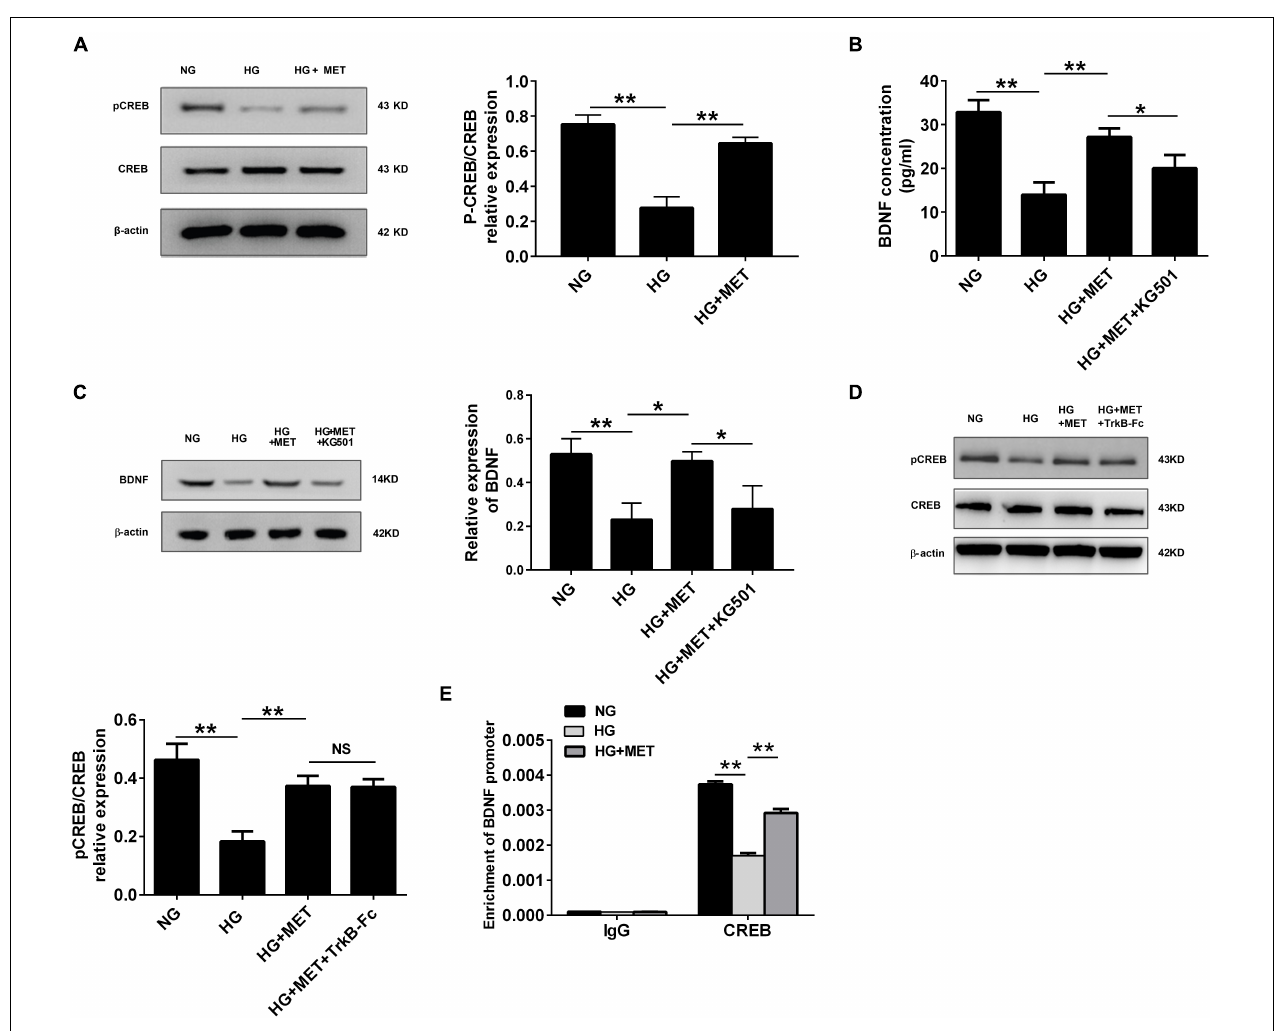
FIGURE 5 | BDNF expression was regulated by metformin through CREB activation. (A) Western blot analysis of CREB and pCREB expression in HUVECs treated with NG, HG (33.3 mmol/l), and HG + MET (0.01 mmol/l) conditions. Histograms represent the relative pCREB/CREB intensity. (B) ELISA analysis of BDNF expression in HUVECs treated with the NG, HG, HG + MET, and HG + MET plus 25 µ M KG501 (HG + MET + KG501) conditions for 24 h. (C) Western blot analysis of BDNF expression in HUVECs treated with NG, HG, HG + MET, and HG + MET + KG501. Histograms represent the relative BDNF intensity. (D) Western blot analysis of CREB and pCREB expression in HUVECs treated with NG, HG, HG + MET, and HG + MET + TrkB-Fc. Histograms represent the relative pCREB/CREB intensity. (E) Detection of CREB binding in BDNF promoter regions by chromatin immunoprecipitation (ChIP) assay in HUVECs. Human IgG was used as a negative control. The results are expressed as the means ± SD. ∗ p < 0.05, ∗∗ p < 0.01; NS, not significant; one-way